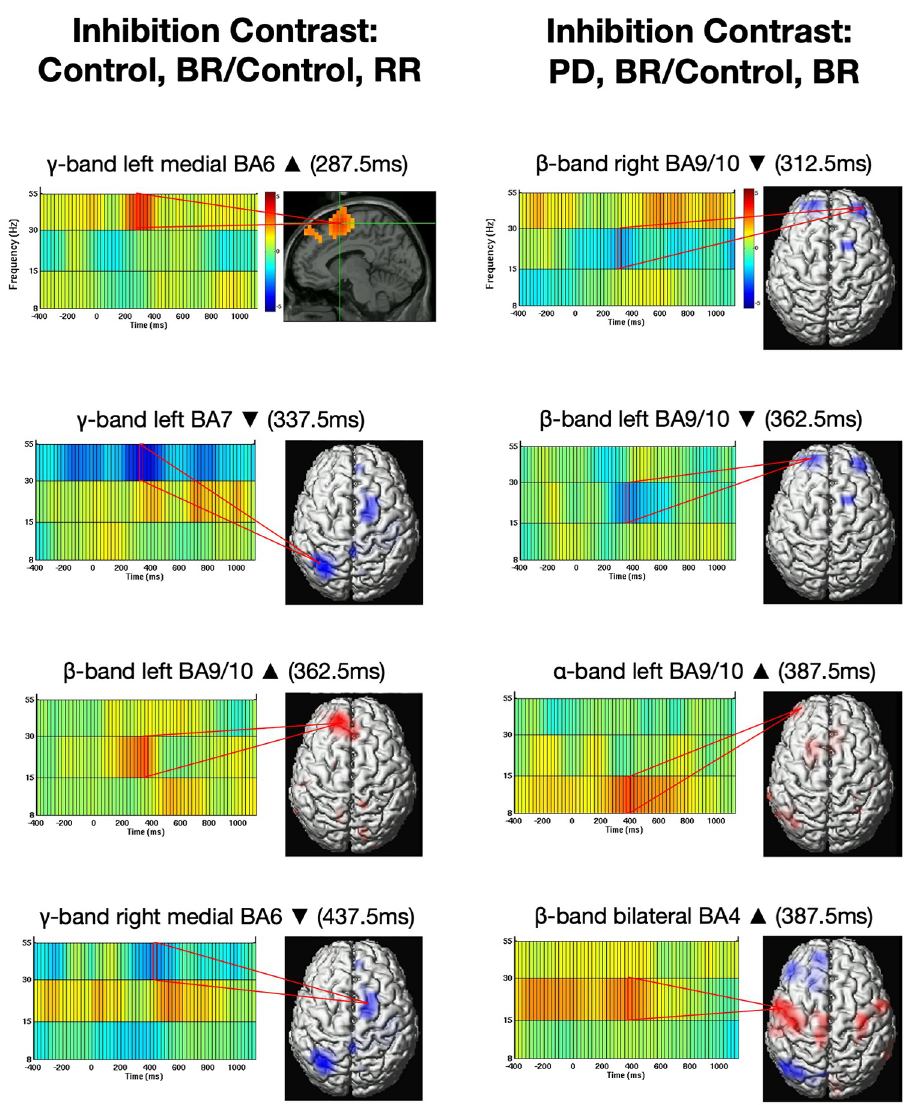
Fig 4. Inhibition contrast analysis. (A) Differences in peak power change in the control group for mismatched inhibition trials versus matched control trials. (B) Differences in peak power change during mismatched inhibition task between the PD and control groups. Conventions as in Fig